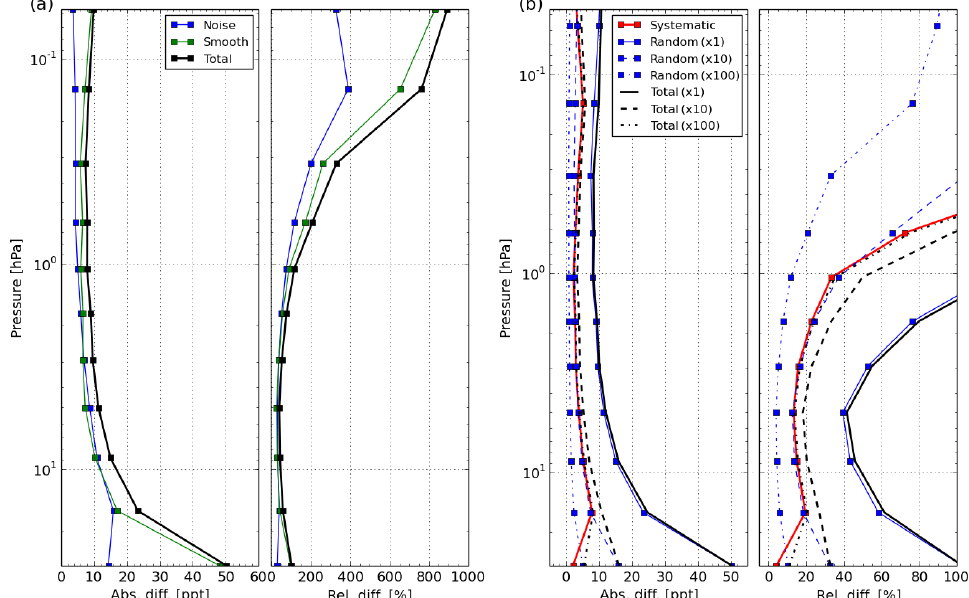
Figure 5. (a) Summary of absolute and relative differences derived from random errors of CH 3 CN retrieved from a SMILES single-scan observation as shown in Fig. 4. (b) Summary of absolute and relative differences derived from random (blue), systematic (red), and total (black) errors in the SMILES CH 3 CN retrieval for the averaging of N profiles ( N = 1, 10, 100). The number in the legend is the accumulating profile